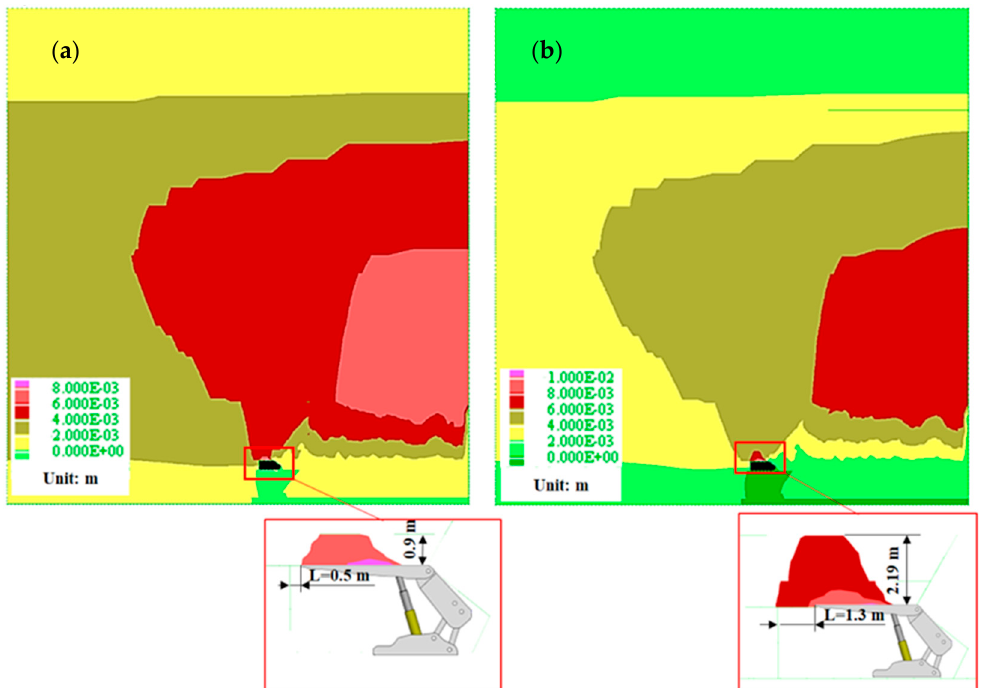
Figure 13. Vertical displacements in the rock mass model for the considered variant I, where: ( a ) before the web cut, ( b ) after the web cut.